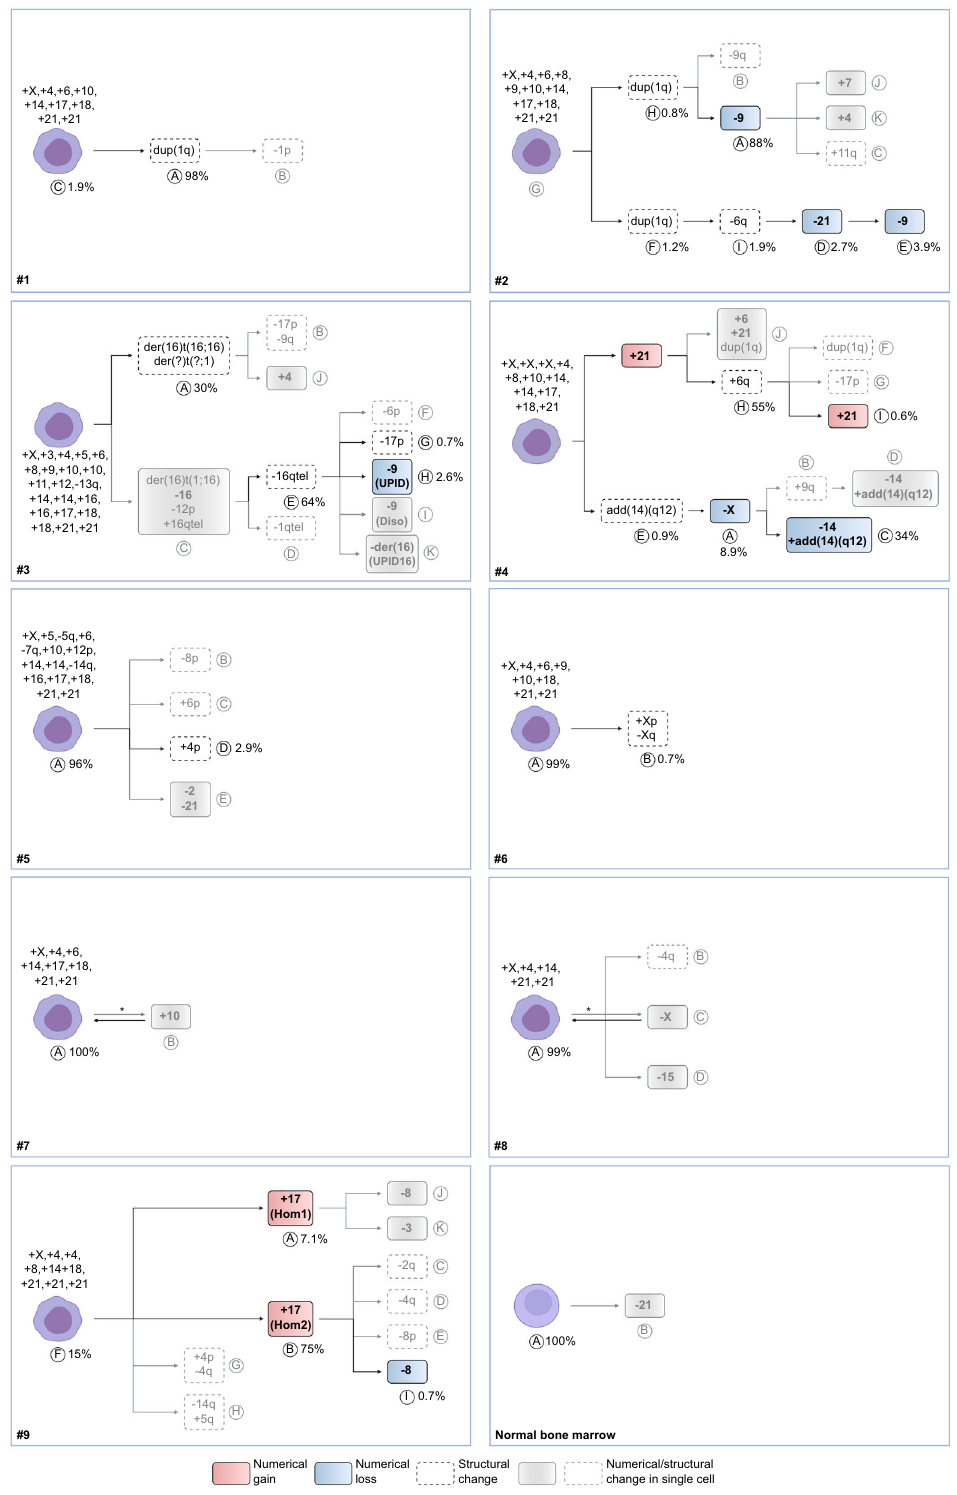
Fig. 2 | Phylogenetic trees showing the most probable course of genetic evo- lution,basedonsinglecellwholegenomesequencing(scWGS),bulkWGS,and fl uorescence in situ hybridization in nine primary childhood acute lympho- blastic leukaemia cases and one normal bone marrow. The bulk of the chro- mosomal gains was present already in the inferred earliest cells, with 1 – 2